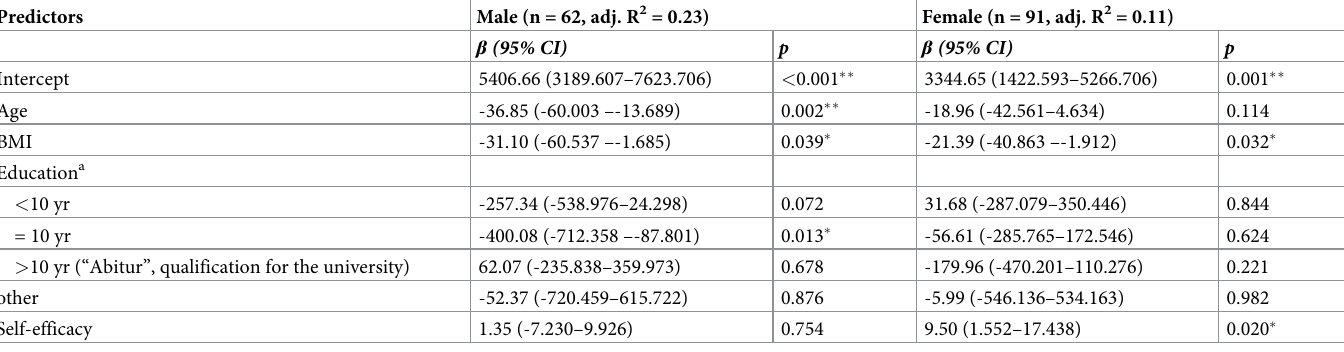
Table 5. Multiple linear regression model to identify determinants for overall PA, separately for men and women. Predictors